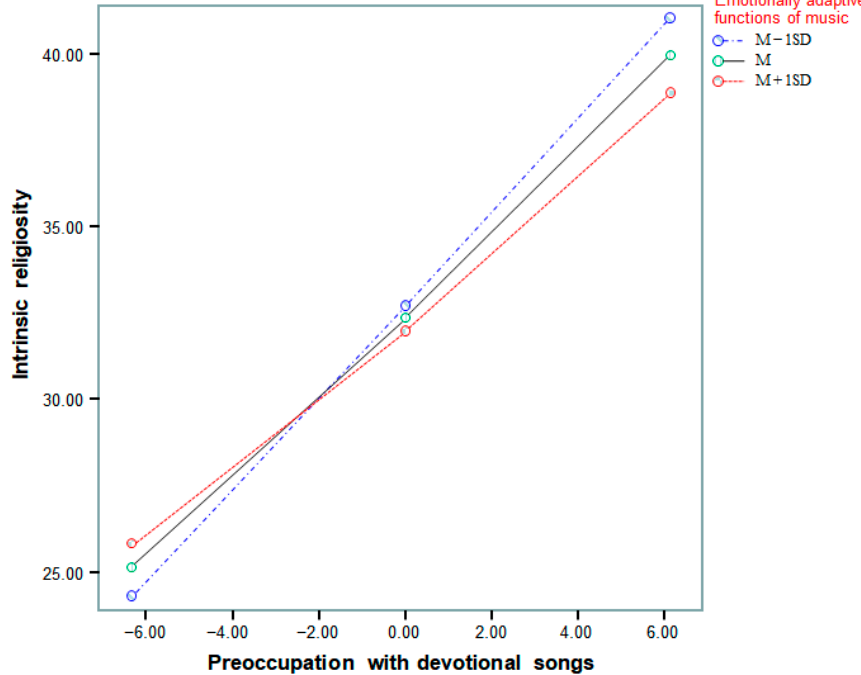
Figure 2. Interaction effect of preoccupation with devotional songs and emotionally adaptive func- tions of music.